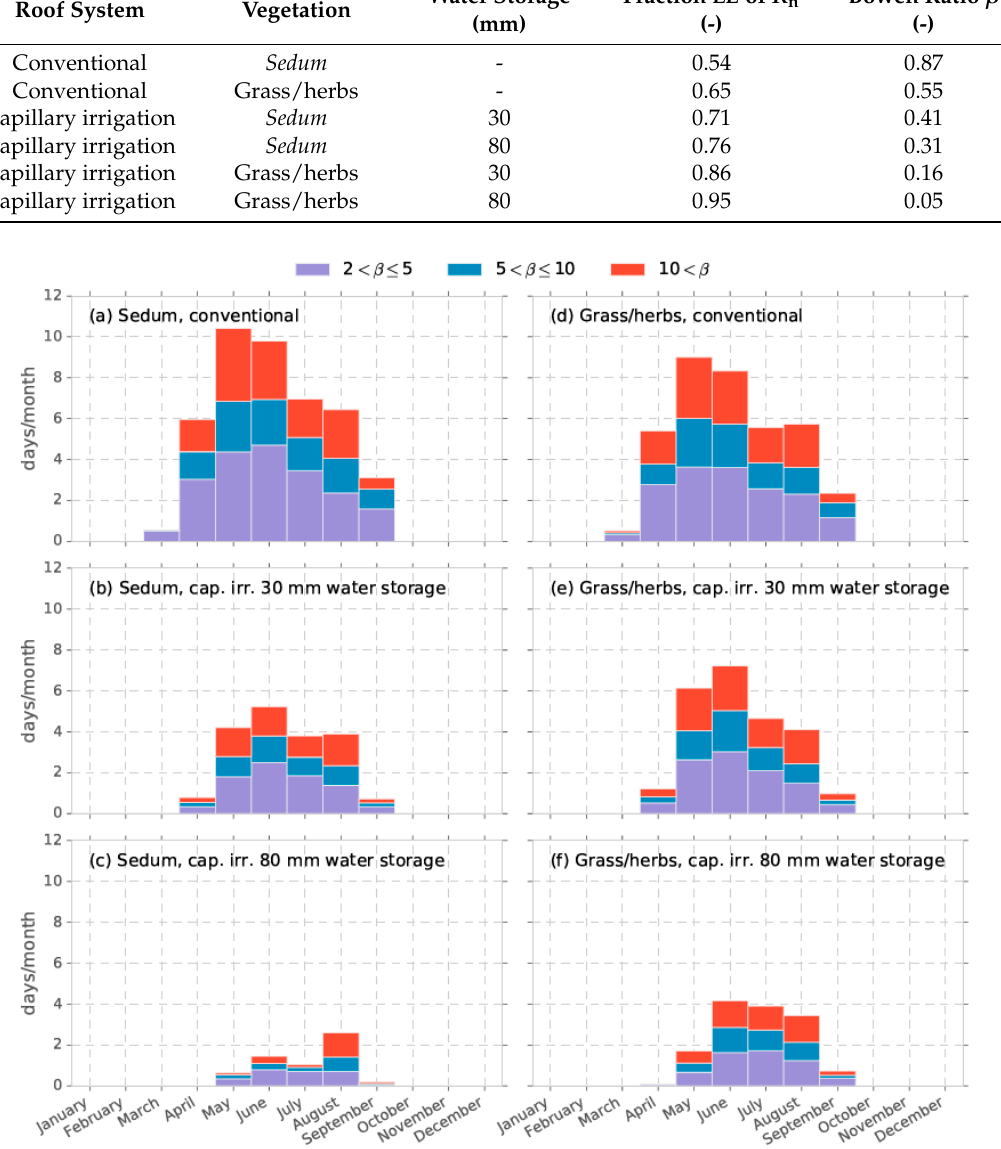
Figure 10. Long-term energy performance of green roof systems expressed in an average number of days per month within a certain Bowen ratio range. The total height of the stacked column denotes the average number of days per month with β >